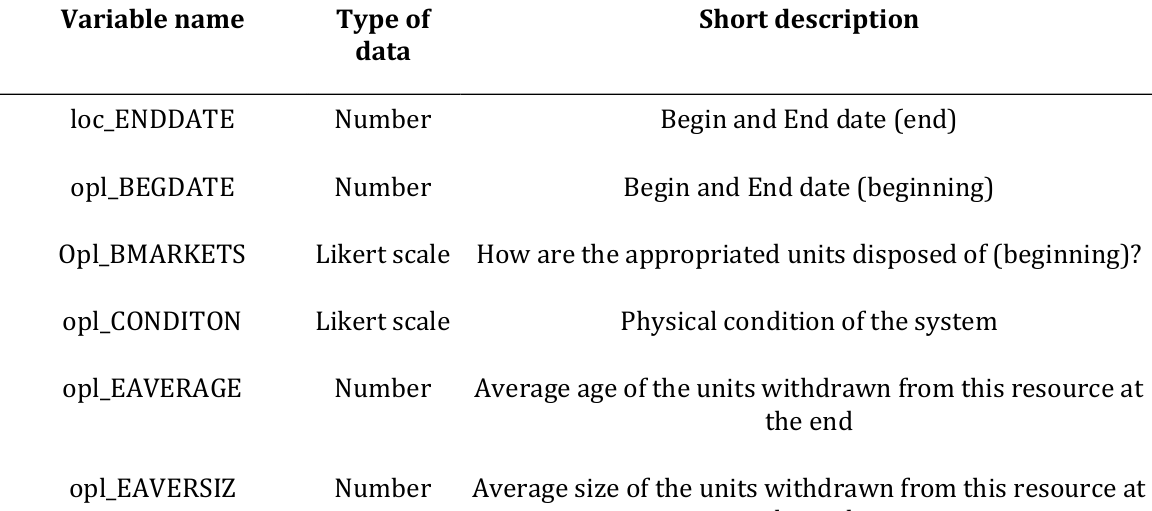
Table A4. Common-pool resouces – Description of variables ecological success consists